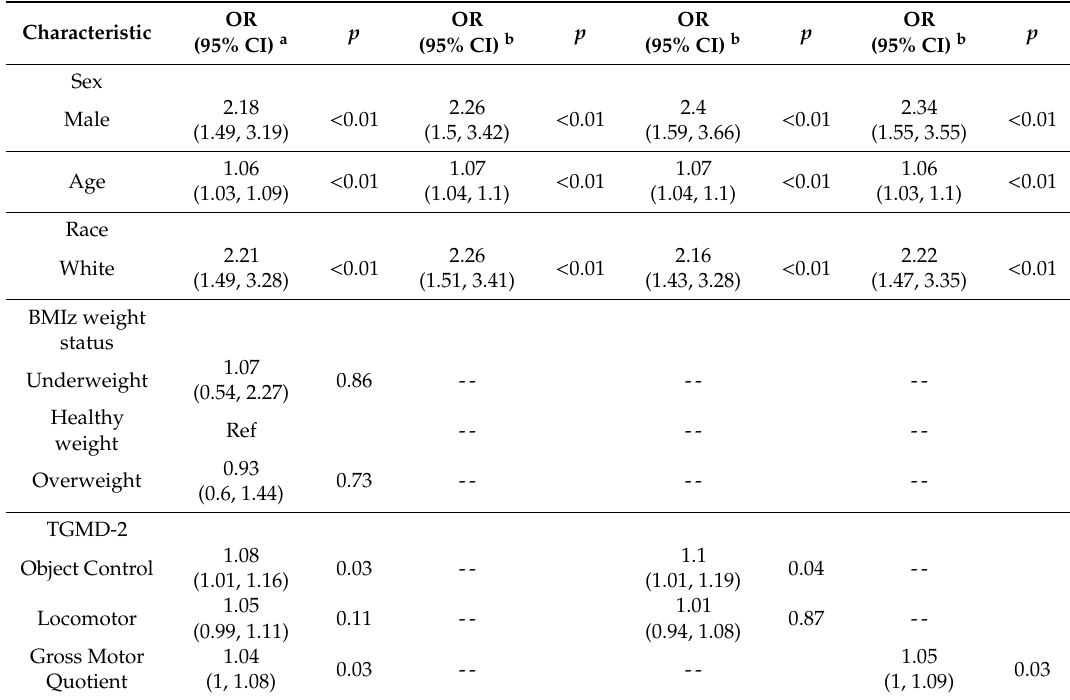
Table 3. Unadjusted and adjusted logistic associations of gross motor development and child demographics with meeting moderate-to-vigorous physical activity guidelines per